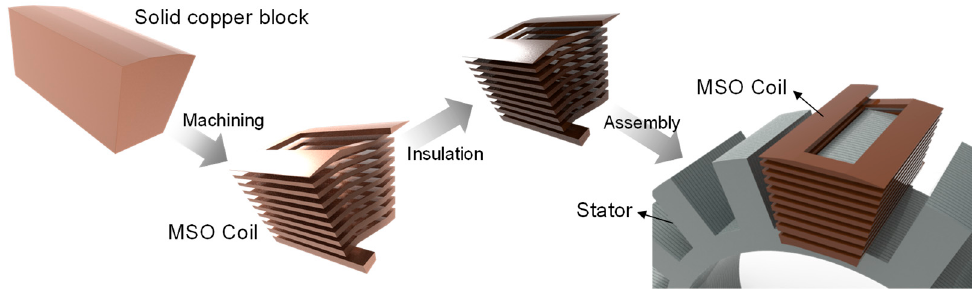
Figure 1. Manufacturing process of MSO